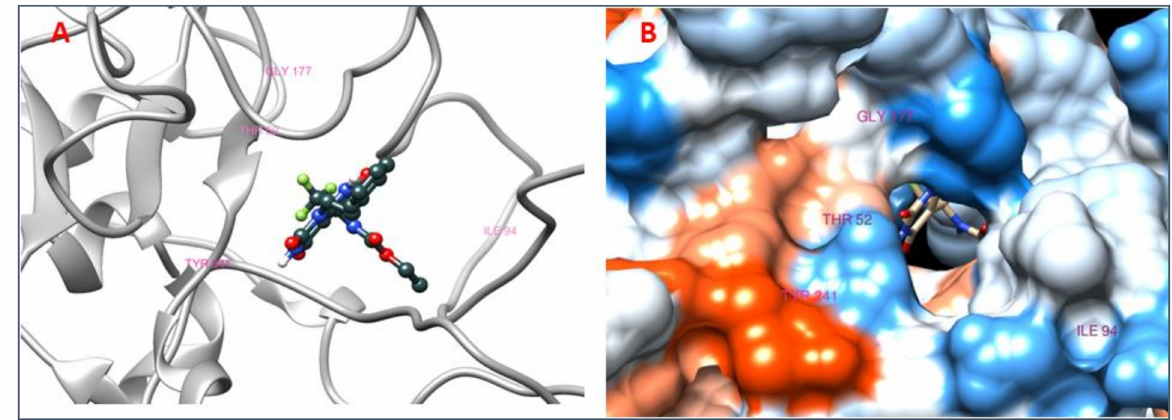
Figure 11. ( A ) 3D interactions of [(2R,3R)-2-[2-[6-[(2R,3R)-5,7-dihydroxy-3-(3,4,5-trihydroxybenzoyl)oxy-3,4-dihydro- 2H-chromen-2-yl]-2,3,4-trihydroxyphenyl]-3,4,5-trihydroxyphenyl]-5,7-dihydroxy-3,4-dihydro-2H-chromen-3-yl] 3,4,5- trihydroxybenzoate and HCV E2 protein having binding affinity − 12. ( B ) Surface representation of interaction.